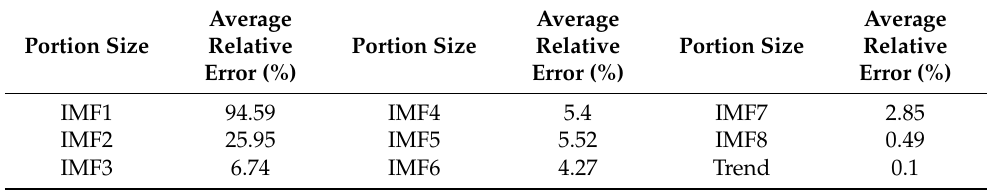
Table 4. Mean relative error of IMF1-8.